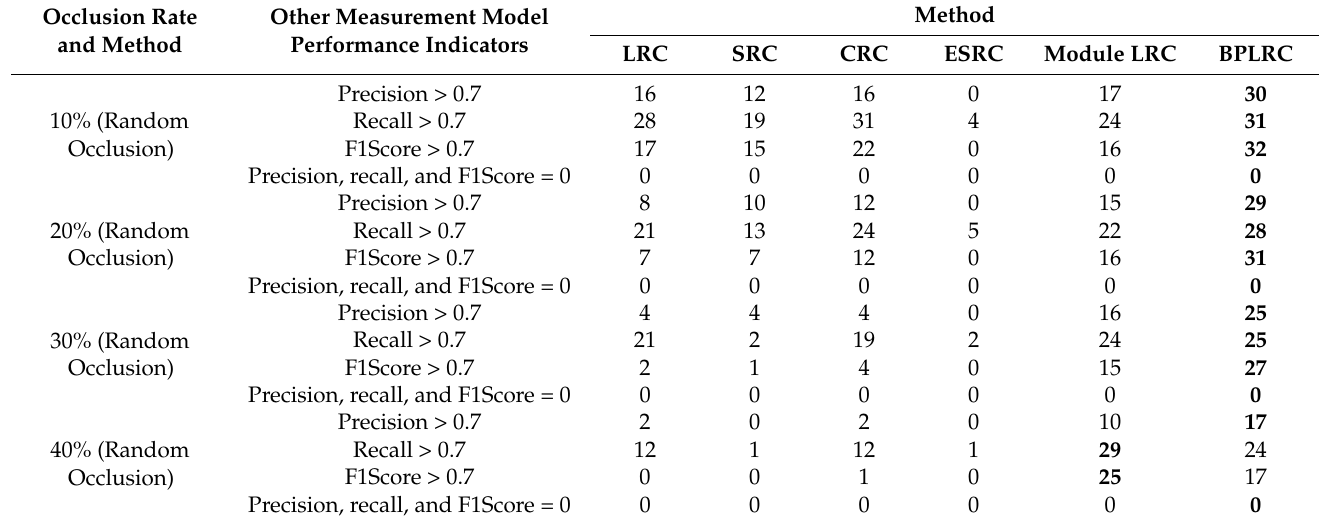
Table 11. The number of categories that identified performance indicators to an extent greater than 0.7 or single categories that were wrongly identified from Extended Yale B datasets for different